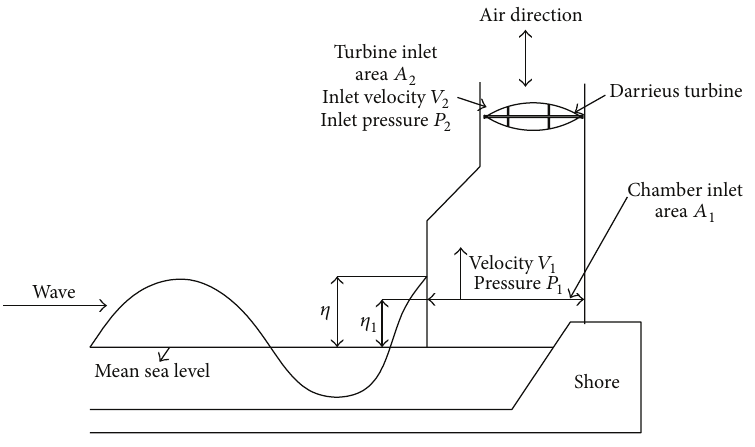
Figure 6: OWC chamber